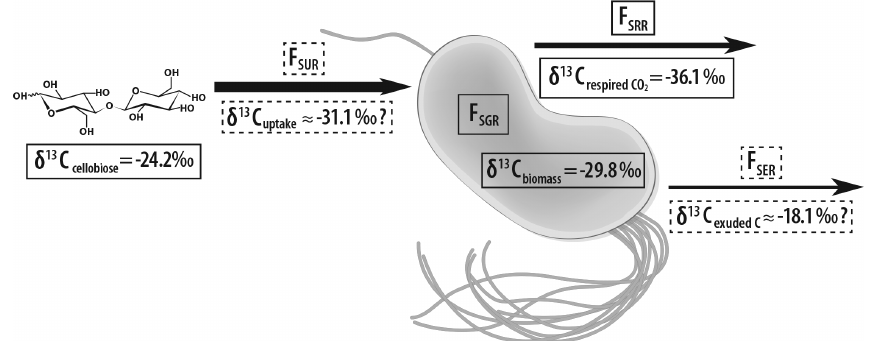
Figure 5. Schematic of an individual P. fluorescens cell, representing the sample population growing at 23.5 ◦ C with one available substrate at a constant relative growth rate of 0.14h − 1 at steady state (Fig. 2), with measured (solid boxes) and estimated (dashed boxes) magnitudes of C and 13 C fluxes into and out of the population. Designated fluxes include specific uptake rate of cellobiose ( F SUR ) , specific growth rate ( F SGR ) , specific respiration rate ( F SRR ) , and specific excretion rate ( F SER ) , in relation to steady-state biomass C in the chemostat, where F SUR = F SGR + F SRR + F SER . The estimate of δ 13 C uptake is based on the assumption that δ 13 C exuded C is 11.7‰ less negative than δ 13 C biomass (Blair et al., 1985) and that F SER is 10% of the sum of F SGR and F SRR (El-Mansi and Holms, 1989). In contrast to this experimental system, in natural environments measurements of boxed pools and fluxes can be confounded by the presence of dormant microorganisms, unknown microbial growth rates, diverse available substrates, and a lack of steady-state CO 2 fluxes.